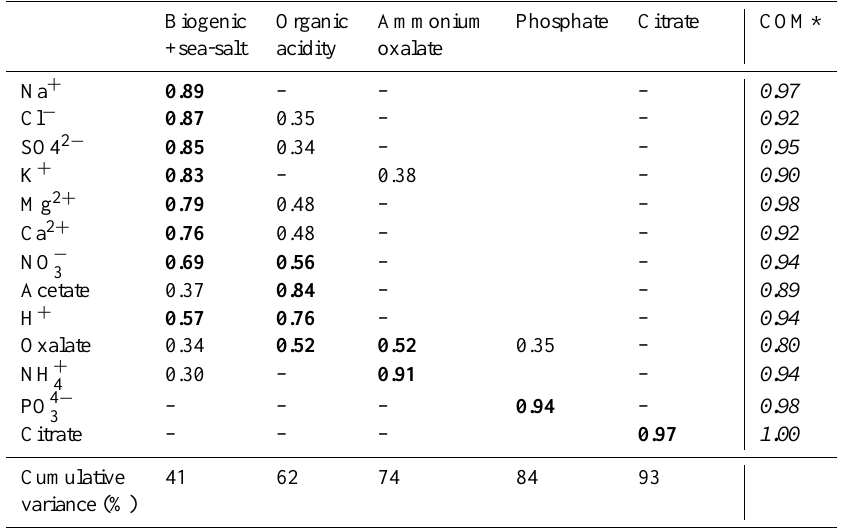
Table 6. Component loadings resulted from the application of Principal Component Analysis application on the rainwater chemistry data. Loading values smaller than 0.30 were omitted. In the last line, it is shown the cumulative explained variance of the